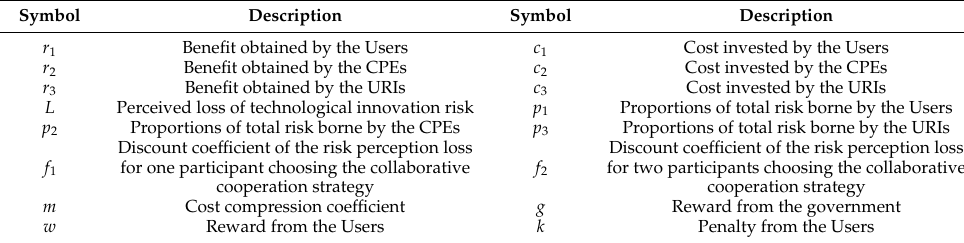
Table 2. Glossary of symbols and